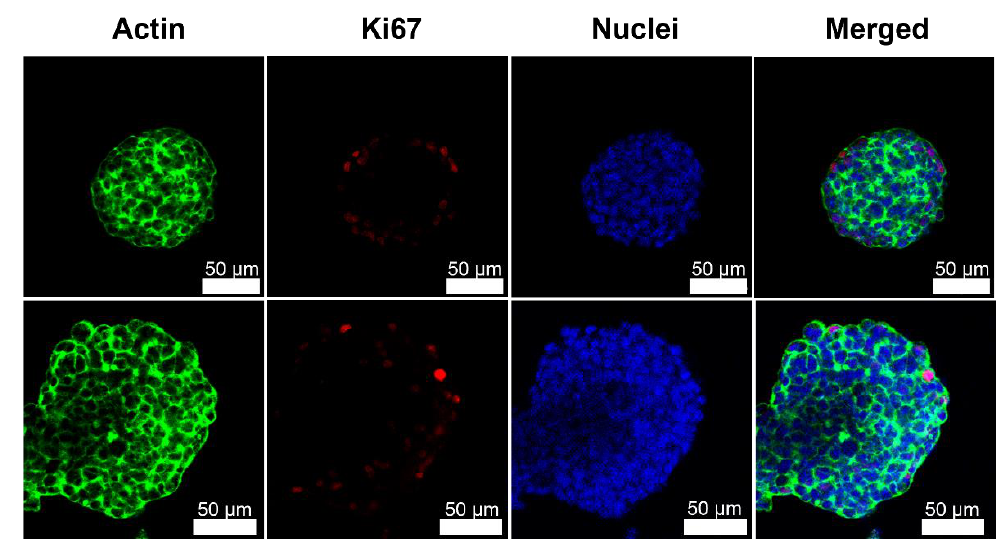
Figure 4. Immunocytochemical staining shows robust cell adhesion by actin (green), some prolifer- ating cells (red) on the outer sphere of the cell spheroid, and disorganized nuclei (blue) locations of HepG2 cell spheroids cultured in fresh 0.8% NFC hydrogel (control) and freeze-dried and reconsti- tuted 0.8% NFC hydrogel (sample). Green: Phalloidin conjugated Alexa Fluor 488. Red: Alexa Fluor 594. Blue: DAPI.